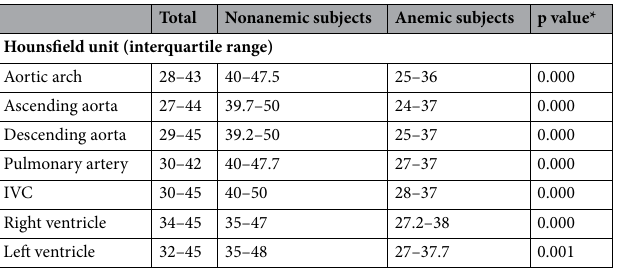
Table 2. Mean blood attenuation in various anatomic locations. IVC inferior vena cava. *Mann Whitney test.